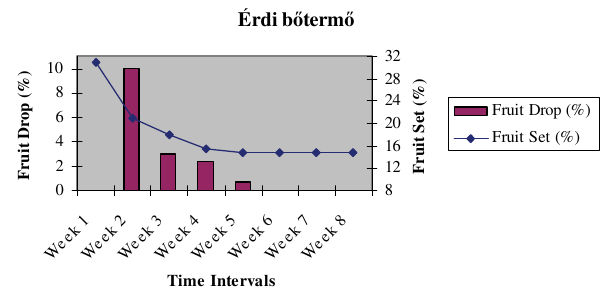
Figure 4 . Seasonal changes of fruit set and drop of 9 sour cherry cultivars